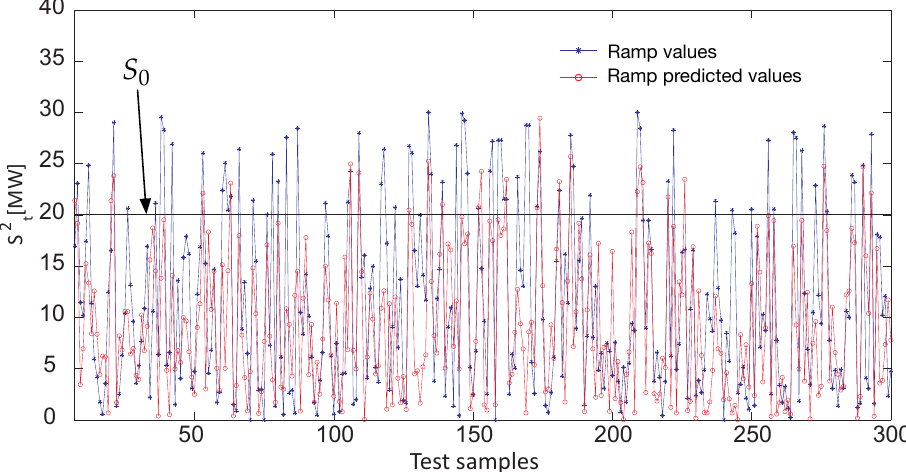
Figure 7. Estimation of the ramp function S 2 t ( Expression (2) ) obtained by the proposed method when using the ELM regressor, in Wind Farm C. The predicted series follows the measured series with RMSE ≈ 5.86 MW and MAE ≈ 4.43 MW, s (ramp) = 58.16% and s (no ramp) = 92.10% (see Table